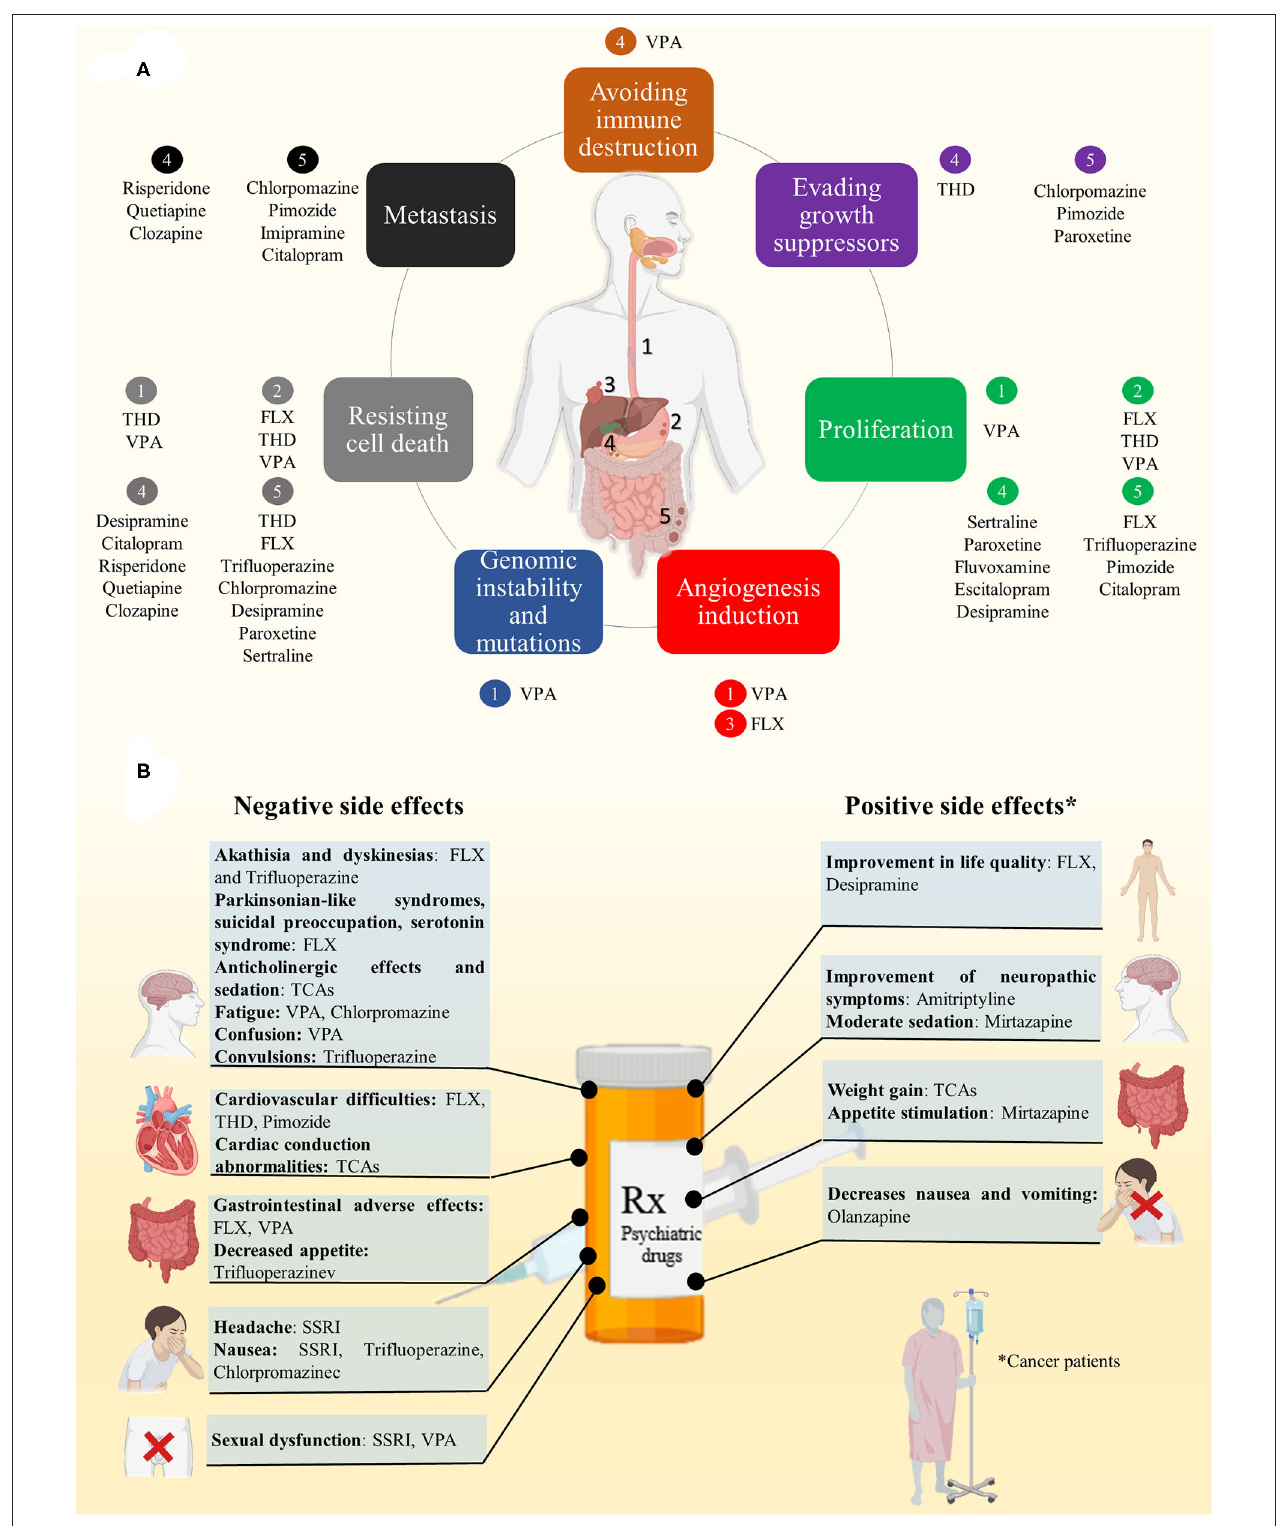
FIGURE 1 | (A) Refocusing psychiatric drugs in GICs. PDs have shown inhibitory potential on carcinogenic processes, such as, growth, proliferation, angiogenesis, metastasis and cell survival on esophageal (1), gastric (2), liver (3), pancreatic (4), and colorectal cancer (5). (B) PDs exhibit positive and negative side effects that could affect the general state of patients and need to be considered.